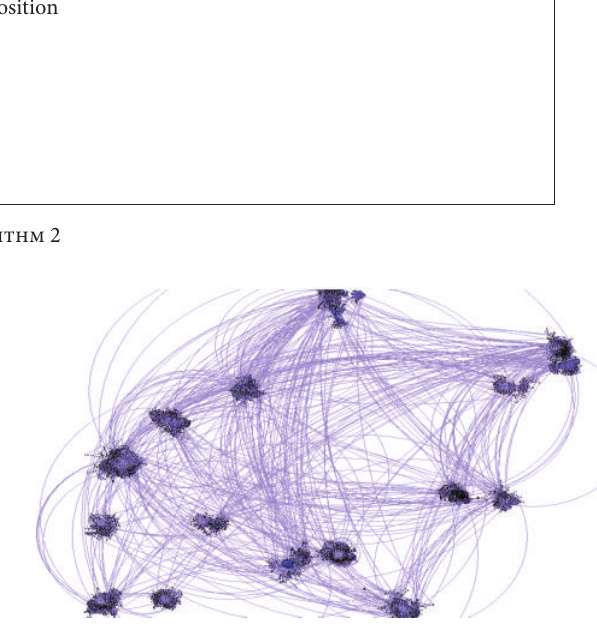
Figure 5: The subgraph display of the network logical topology in China.